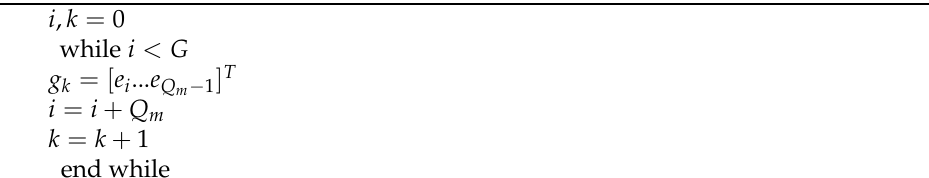
Algorithm 1: Reduced multiplexing